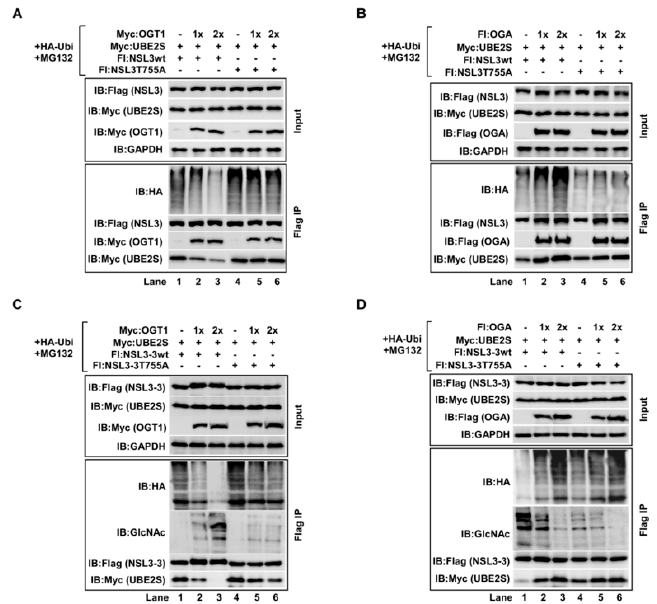
Figure 5. Stabilization of NSL3 was regulated by O -GlcNAcylation of NSL3 Thr755 site. “ + , − ”